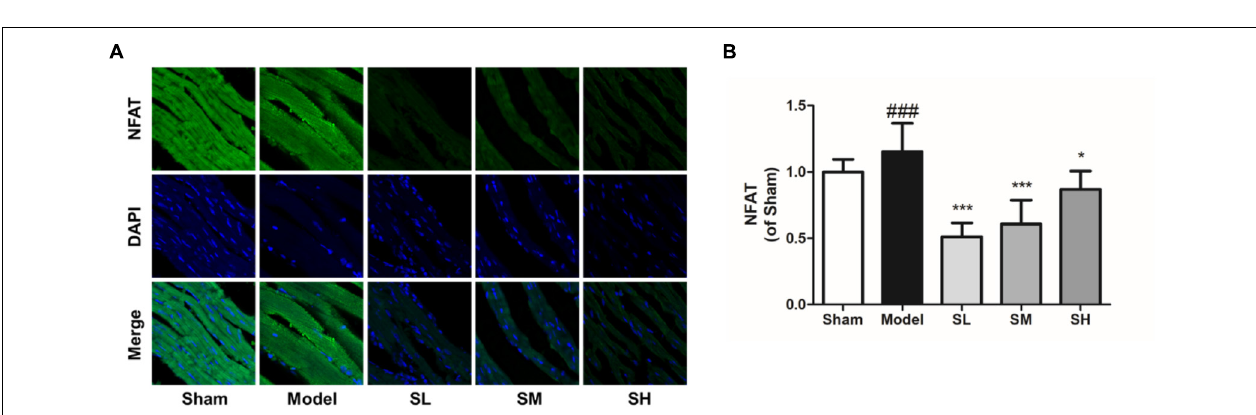
FIGURE 11 | The blood flux (B) and clotting time (C) of AMI mice after treatment with Schisandra . (A) The mice were injected with Adr and then stimulated through 4 ◦ C water. After repeating these procedures twice, the FLPI was used to test blood flow in the ear vein. Then one drop of blood was taken for the test of clotting time by counting the seconds when the blood started to coagulate. All data are shown as the mean ± SD. # P < 0.05, ## P < 0.01 vs. Sham group; ∗ P < 0.05, ∗∗ P < 0.01 vs. Model group.